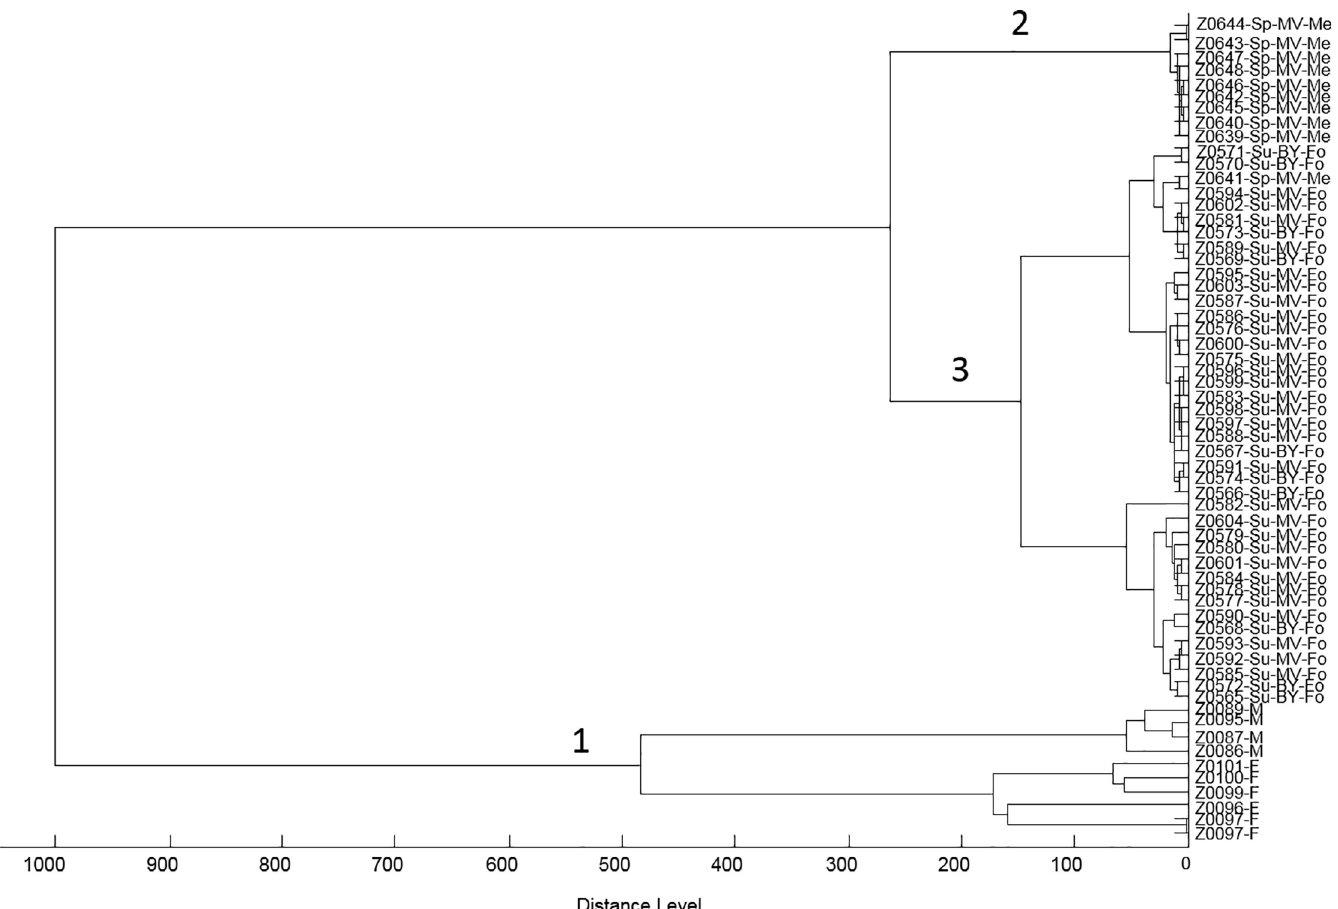
Fig 3. Spectrum-based dendrogram. Three groups of nymphs were included in the dendrogram which were collected during spring in a meadow in Mecklenburg- West Pomerania (Sp-MV-Me) or during summer in a forest in Mecklenburg-West Pomerania (Su-MV-Fo) or Bavaria (Su-BY-Fo). Adult I . ricinus spectra from female (F) and male (M) animals were added (cluster 1) and appeared clearly separated from the nymphs as expected. Nymph spectra separated in two main clusters primarily according to a combination of habitat and season (clusters 2 and 3). Spectra representing samples with differing provenience only (MV or BY, both collected in summer and in a forest) formed a joint group (3) indicating that the geographic location alone does not represent a strong determinant of the spectral phenotype.